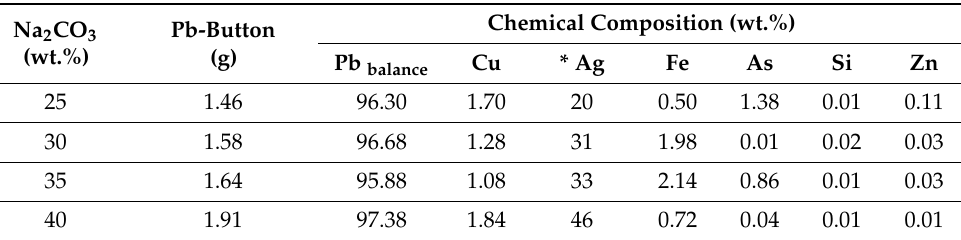
Table 2. Chemical composition and weights of crude lead buttons for different amounts of Na 2 CO 3 (25, 30, 35, and 40 wt.%), and 0.4 g of SiC to 1000 ◦ C. Chemical Composition (wt.%) Na 2 CO 3 Pb-Button (wt.%) (g) Pb balance Cu * Ag Fe As Si Zn 25